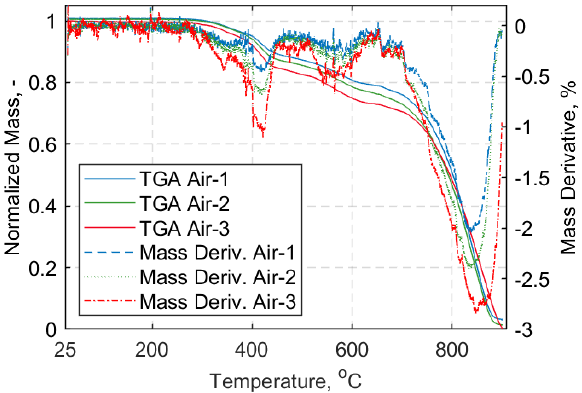
Figure 5. Left : Normalized mass loss curve vs. temperature (°C). Right : Mass derivative curve (%) vs. temperature (°C); air atmosphere for carbon fiber reinforced polymer (CFRP) straps.